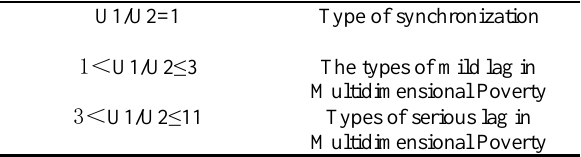
Table 3. Classification criteria of coupling coordinated